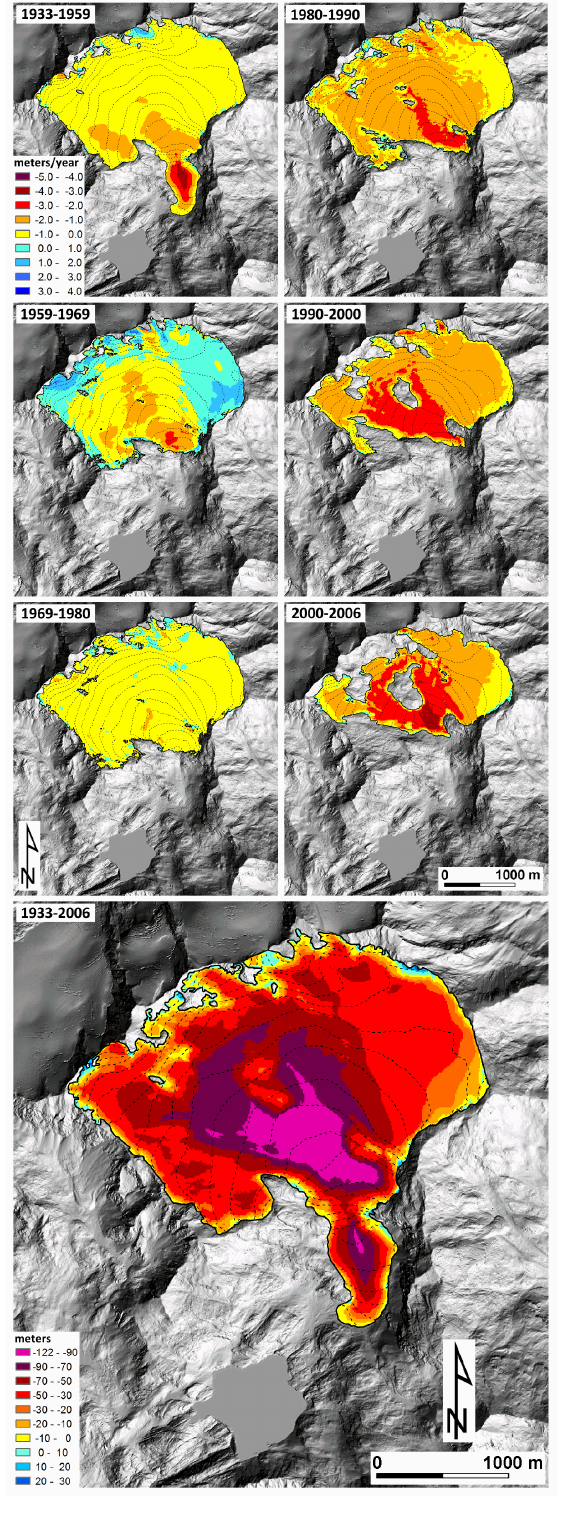
Fig. 7. Mean annual elevation change in six periods (smaller pic- tures) and cumulated elevation change from 1933 to 2006 (larger picture).